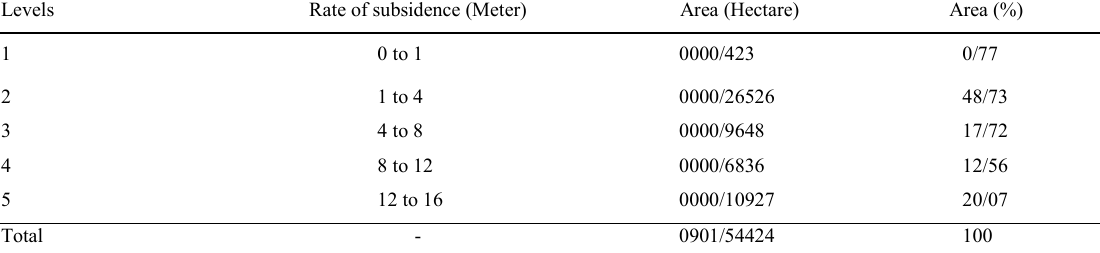
Table 2: Information related to Model output map